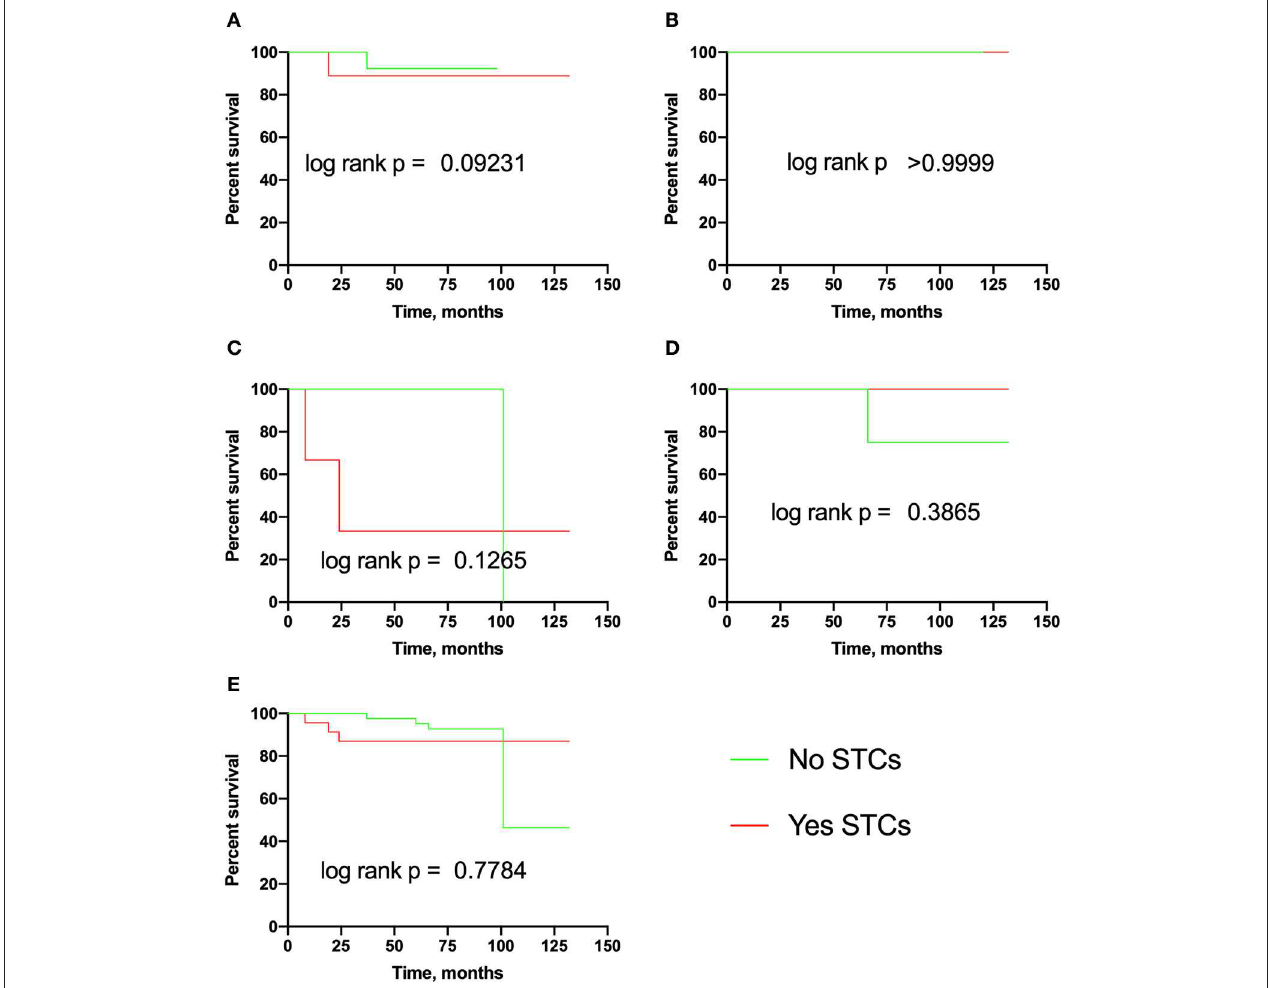
FIGURE 2 | Recurrence-free survival in breast cancer patients with eSTCs. (A) Luminal A. (B) Luminal B. (C) Triple-negative. (D) HER2-positive. (E) Total group.